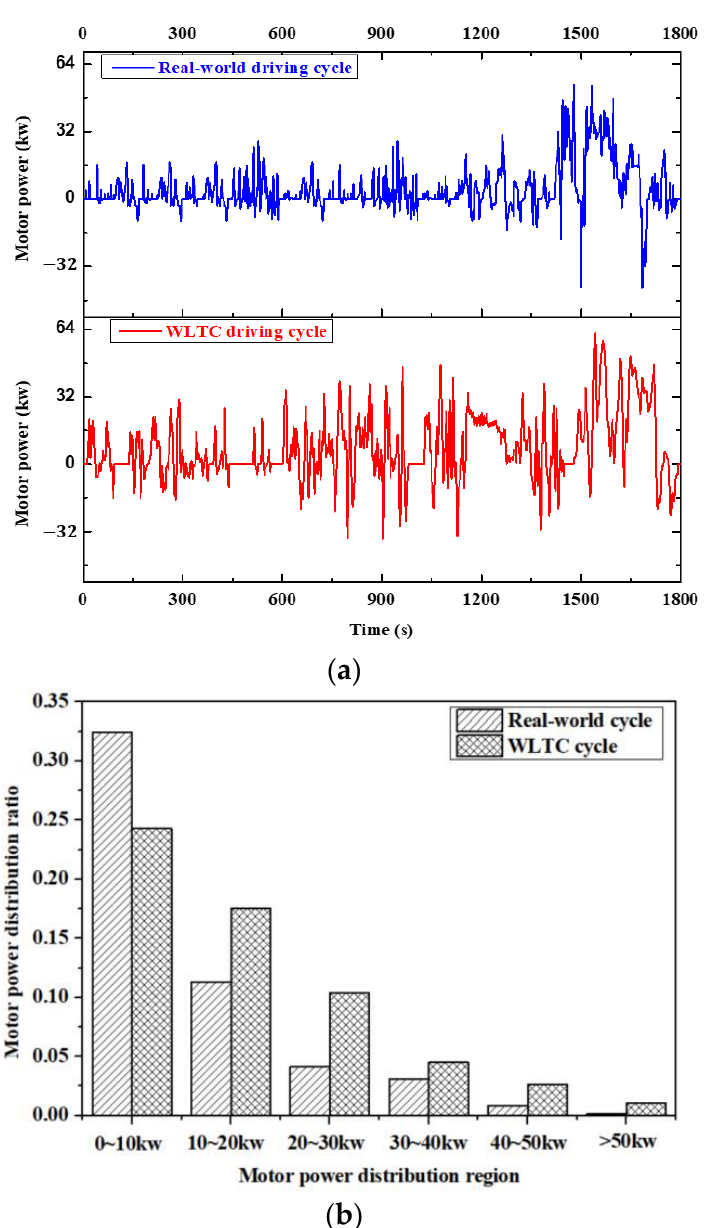
Figure 16. Motor power comparison result between real-world and WLTC driving cycles. ( a ) Comparison of motor power trajectory in an individual cycle; ( b ) comparison of motor power distribution.